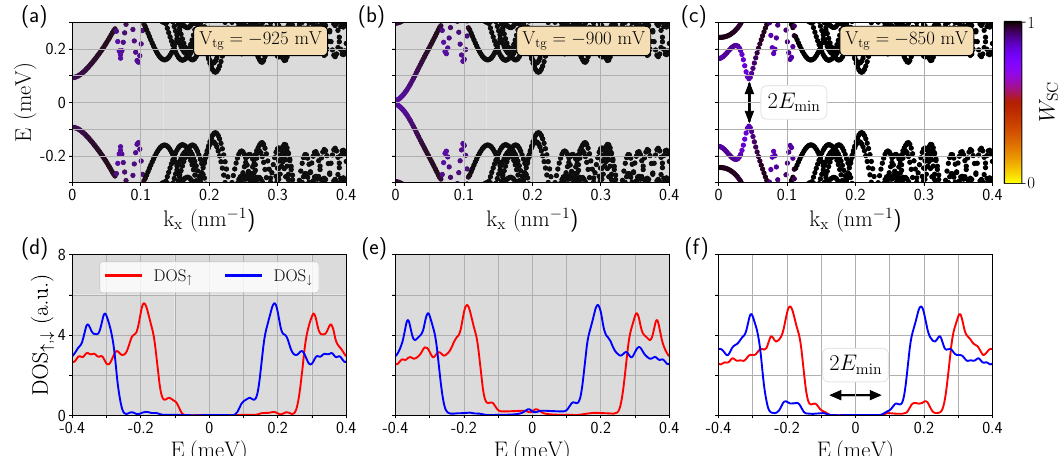
Fig. 3 Topological phase transition and DOS. Dispersion relation for a device with EuS layer thickness d FI = 1.5 nm, and for ( a ) V tg = − 925 mV (before the topological transition), ( b ) V tg = − 900 mV (at the topological transition), and ( c ) V tg = − 850 V (in the middle of the topological phase). In ( d – f ) we show the spin-resolved integrated DOS of the corresponding plot on the top. Only the ( c , f ) case is topological, with E min being the topological minigap, i.e., the lowest-state energy at k x = k F